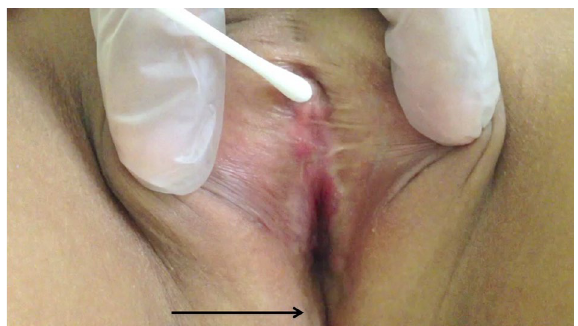
Figure 3. Description of the clitoro-perineal reflex. The reflex was triggered by gentle touch of the glans by a cotton swab. Contraction of the perineal muscles was observed (Arrow). The Video shows how the reflex is triggered with clear observation of perineal muscles contractions, one year after feminizing genitoplasty including clitoral reduction (Video